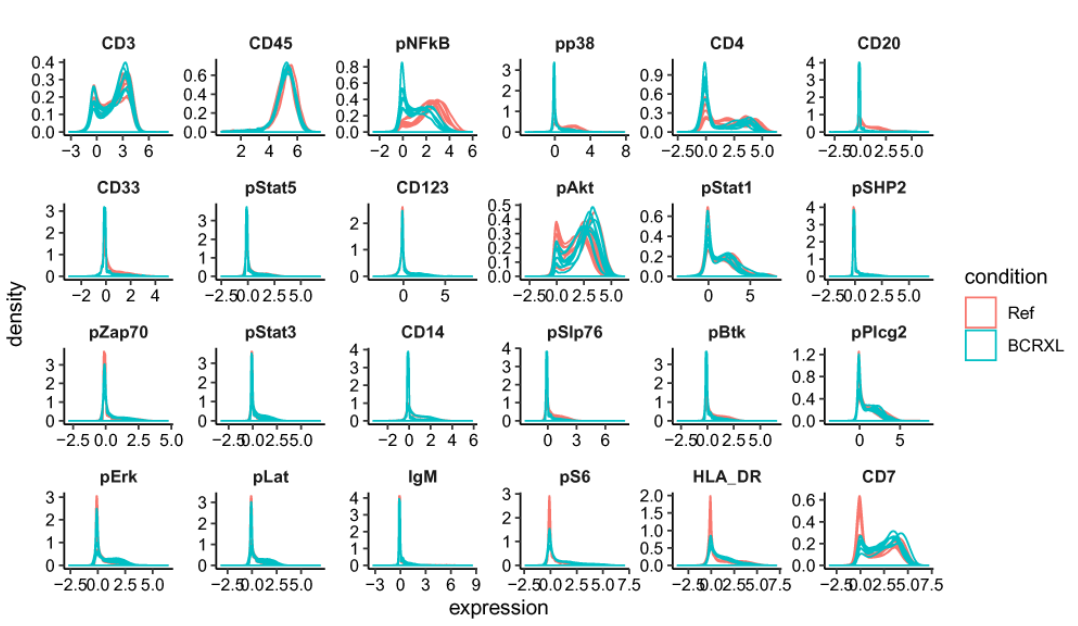
Figure 1. Per-sample smoothed densities of marker expression (arcsinh-transformed) of 10 lineage markers and 14 functional markers in the PBMC dataset. Two conditions: unstimulated (Ref) and stimulated with BCR/FcR-XL (BCRXL) for each of the 8 healthy donors are presented and colored by experimental